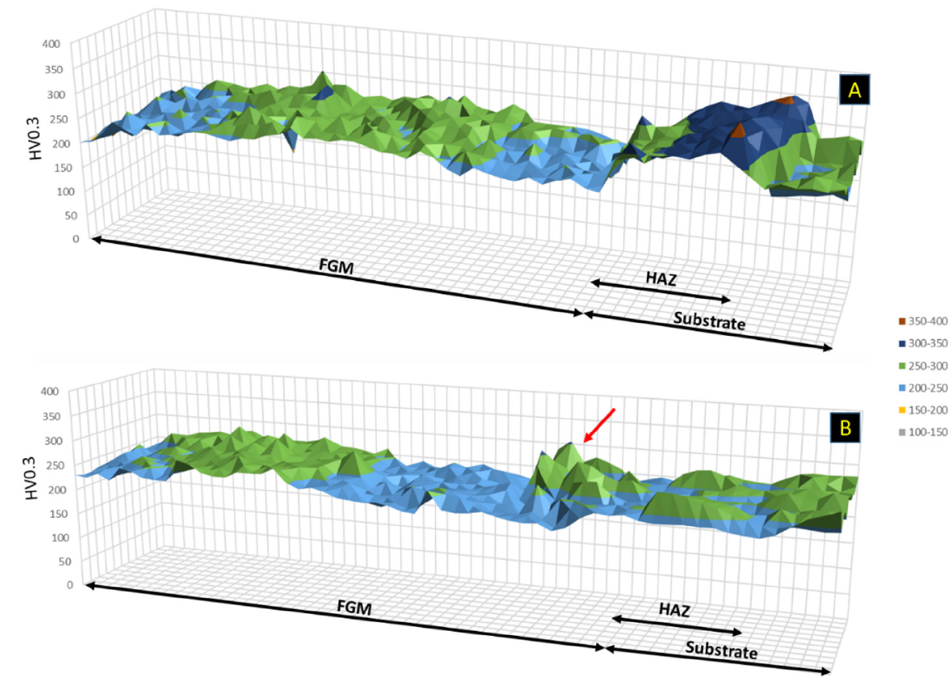
Figure 9. FGM microhardness mapping. ( A ) without PHT and ( B ) with PHT.